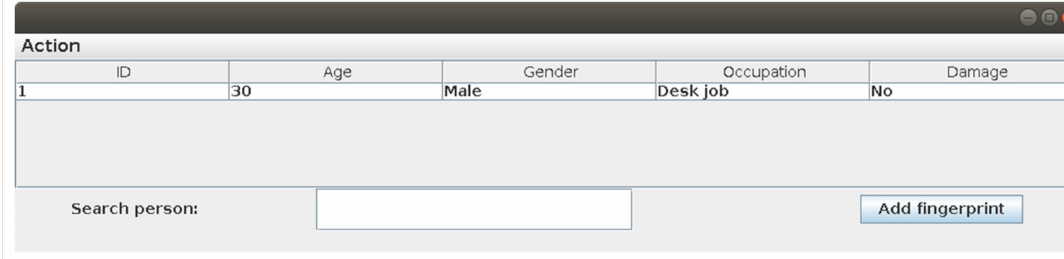
Figure 4. Application form for enrolled users.